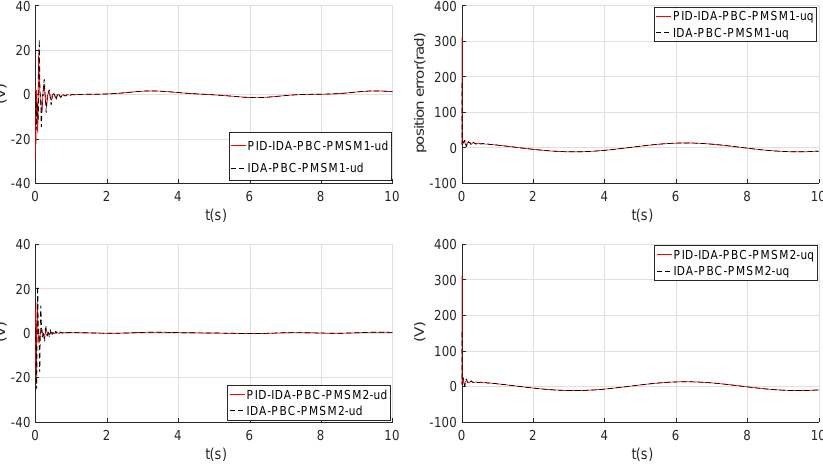
Figure 5. Control voltage of each joint